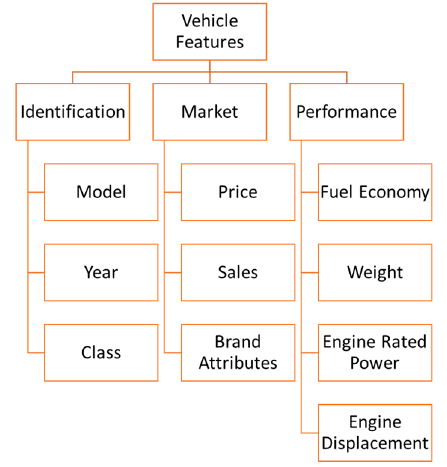
Figure 3. Schematic of major vehicle features in the analyses.